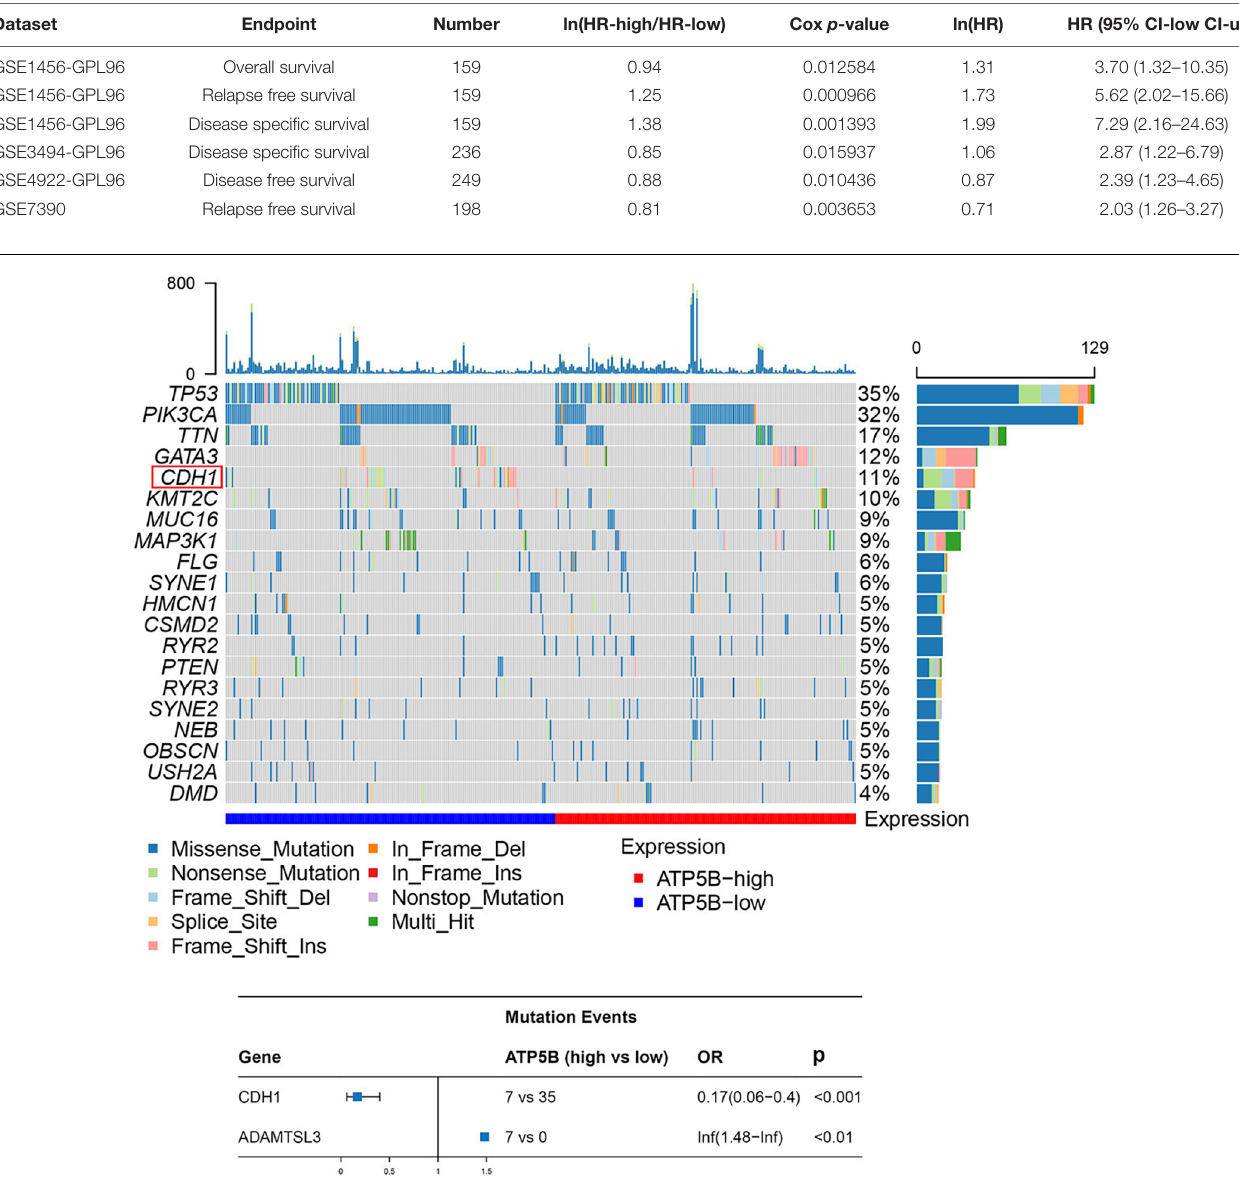
FIGURE 5 | Mutation analysis of ATP5B. The top 20 mutated genes in the breast cancer subsets stratified by ATP5B expression. The red frame represents the mutation with a statistically significant difference ( p < 0.05). At the bottom is a forest plot of significantly mutated genes. Consider only genes with at least three samples mutated in one of the cohort for